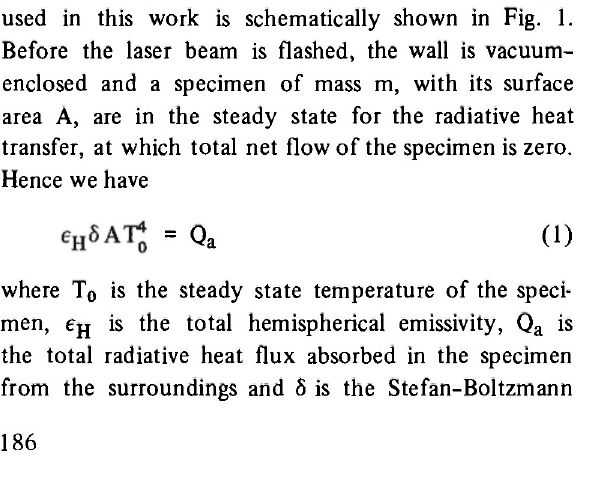
Fig. 1. Schematic diagram of emittance